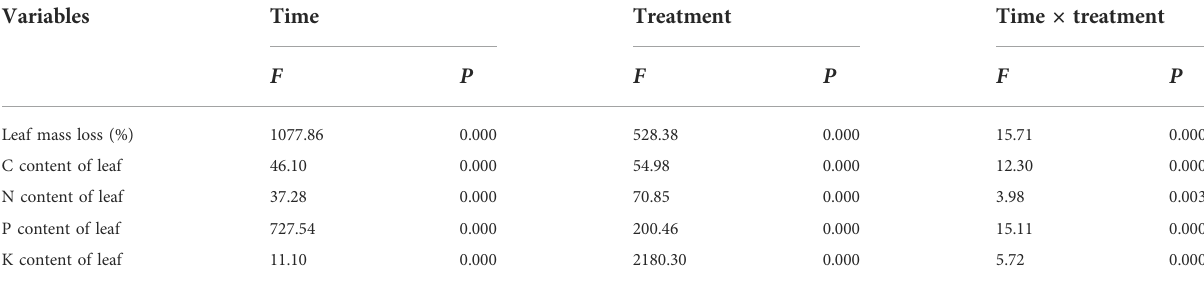
TABLE 1Resultsof repeatedmeasureanalysis of variance for mass loss and nutrient content under decompositiontimes, water treatments, andtheir interactions in the Three Gorges Reservoir, China. Variables Time